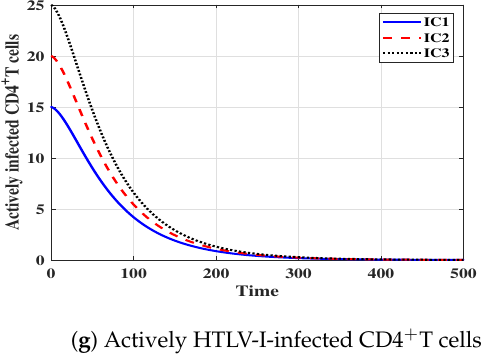
Figure 3. Solutions of system (7)–(13) with initial conditions IC1–IC3 in Case